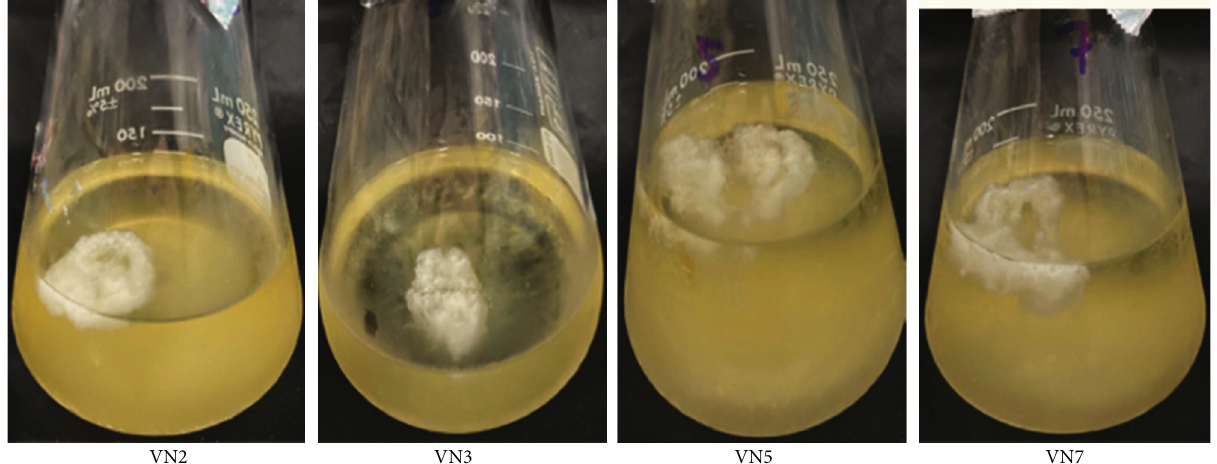
Figure 4: Polymers of EPS in the 30 ml cultures of VN2, VN3, VN5, and VN7, respectively.